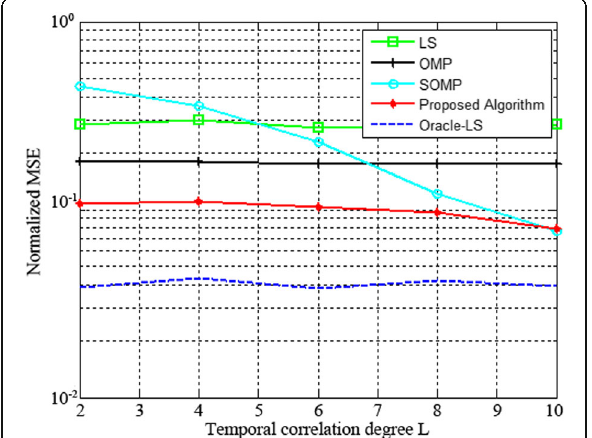
Fig. 1 The NMSE with different temporal correlation degree